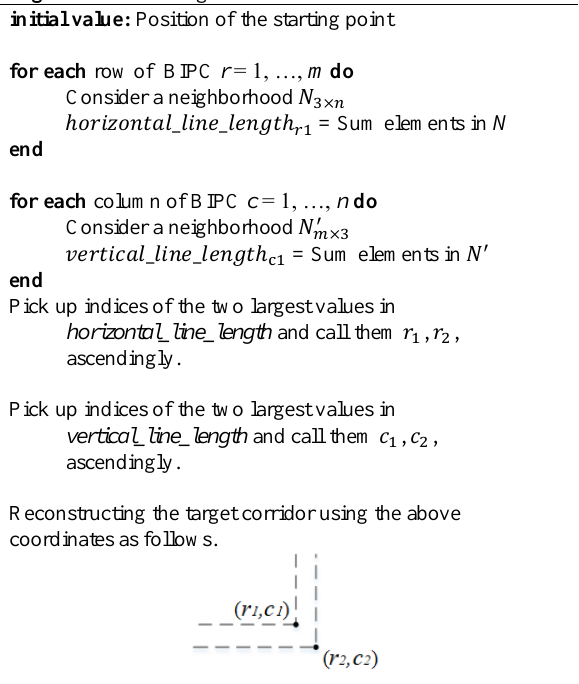
Algorithm 2. Finding corridor walls in the